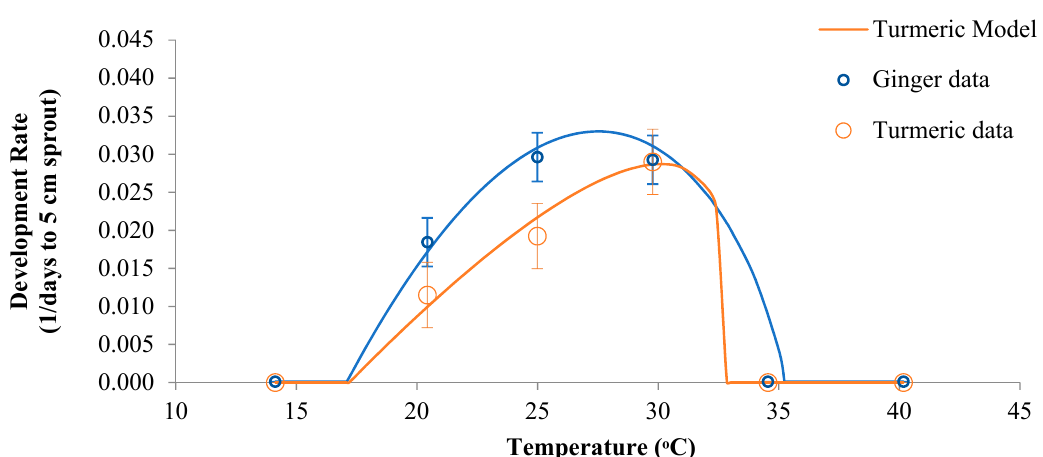
Figure 2. Validation of ginger and turmeric data to the Landsberg function used in Equation (1) based on the parameters from Table 2. Symbols represent the mean ± 95% confidence intervals. Data were pooled across two cultivars and include 12 rhizomes per species per temperature treatment.